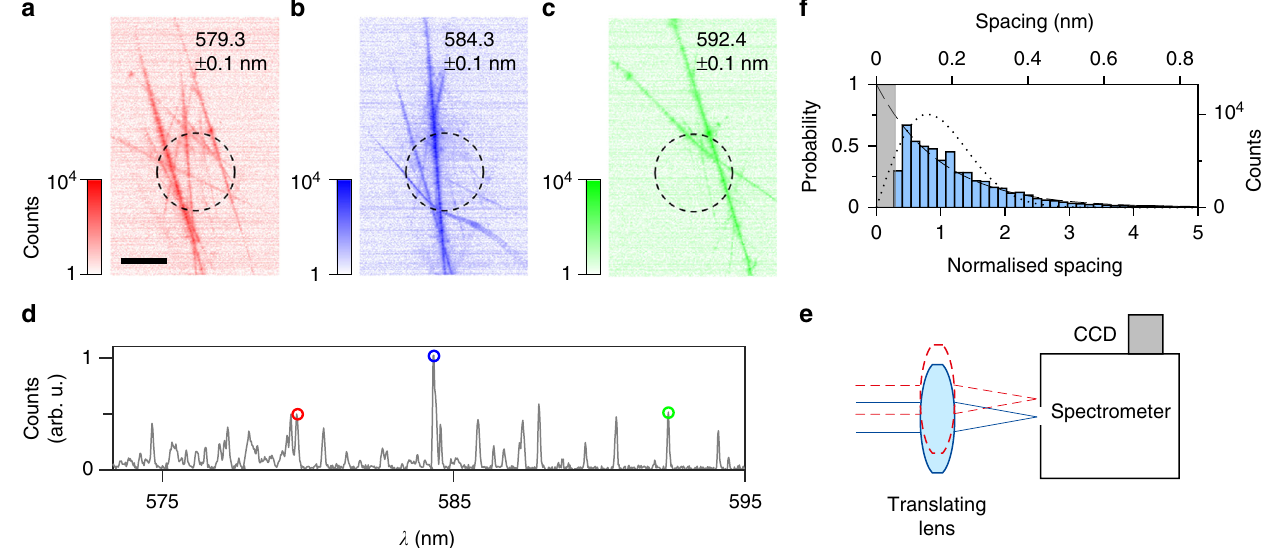
Fig. 2 Characterisation of network lasing modes. Far- fi eld images of the lasing network corresponding to three different lasing modes, at wavelengths: a 579.3 ± 0.1 nm, b 584.3 ± 0.1 nm and c 592.4 ± 0.1 nm. The dashed black circle indicates the pump area. Scale bar is 100 μ m. d Spectral data from the entire area shown in a . Coloured circles indicate the lasing peaks corresponding to the hyperspectral images ( a – c ). Hyperspectral images were obtained by scanning the lens in front of the spectrometer ( e ) and collecting spectral data from different areas of the sample. f Normalised mode spacing statistics obtained from experimentally measured lasing spectra from different parts of the sample. The distribution is well fi tted by an exponential curve (dashed line) up to the experimental spectral resolution indicated by the grey band. Wigner-Dyson distribution (dotted line) is also shown for comparison NATURE COMMUNICATIONS| (2019) 10:226